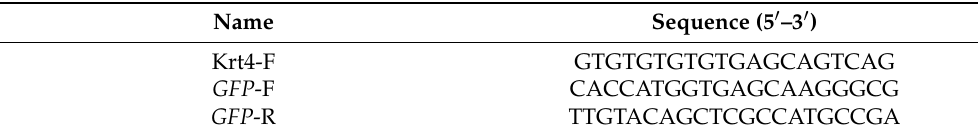
Table 1. Primers for